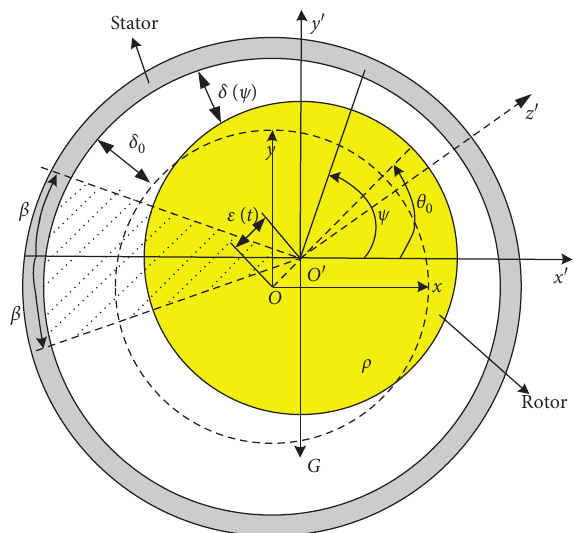
Figure 2: The cross-section diagram of rotor